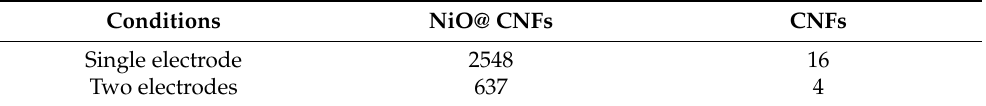
Table 4. Overall specific capacitances in the unities of F g − 1 obtained from the GCD